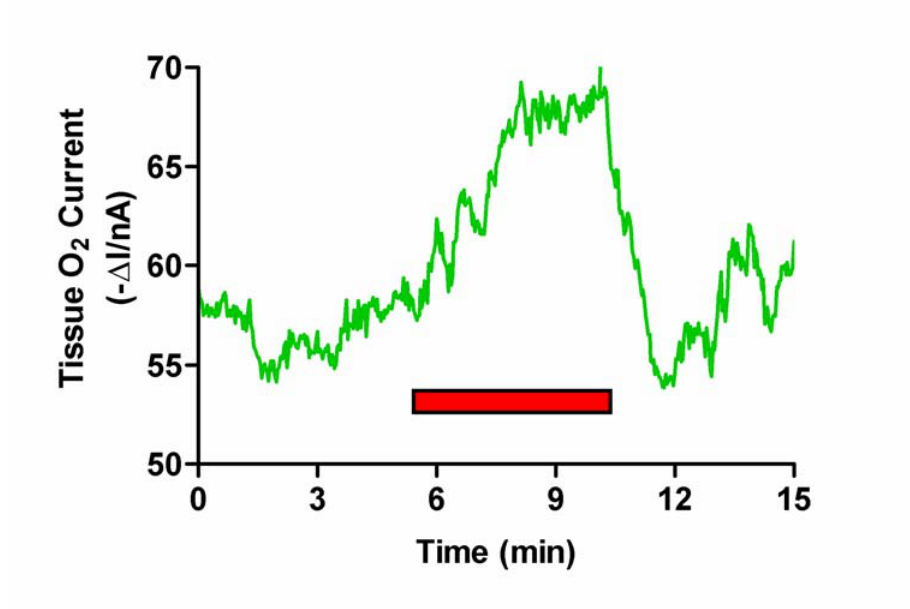
Figure 3. Typical example of the effect of induced grooming (red bar) on striatal O 2 levels monitored with an implanted carbon paste electrode and differential pulse